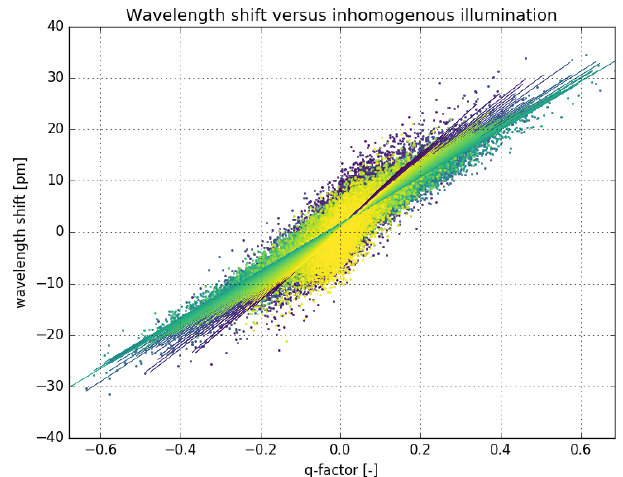
Figure 16. Scatterplot of the radiance wavelength shift for all UV2 pixel radiance values of four orbits spread out over 2005 versus the inhomogeneous slit illumination Q factor. The colors indicate dif- ferent rows. A shift of 30pm corresponds to 0.21 detector pixels in